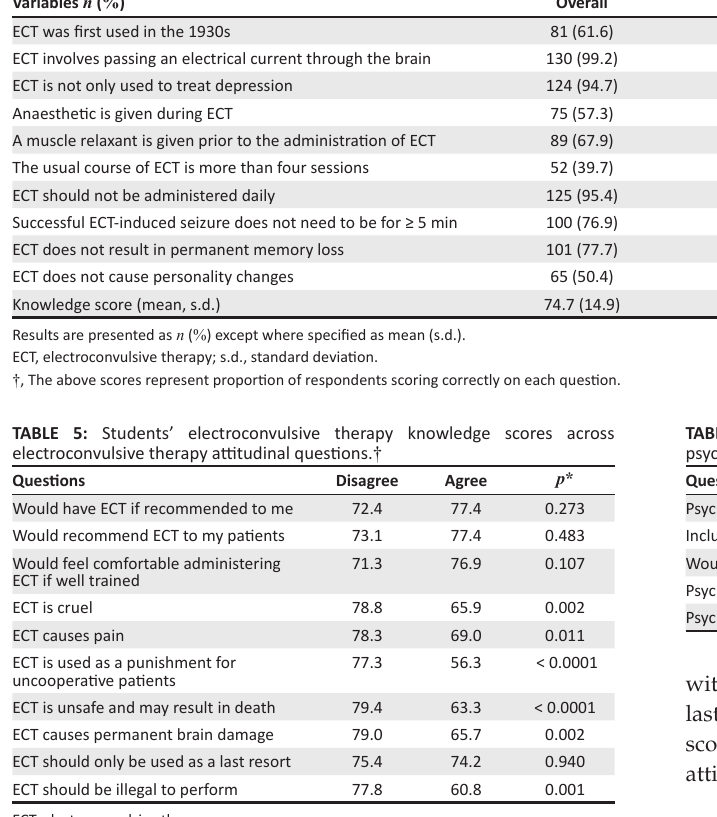
TABLE 4: Students’ knowledge regarding electroconvulsive therapy.† Variables n ( % )